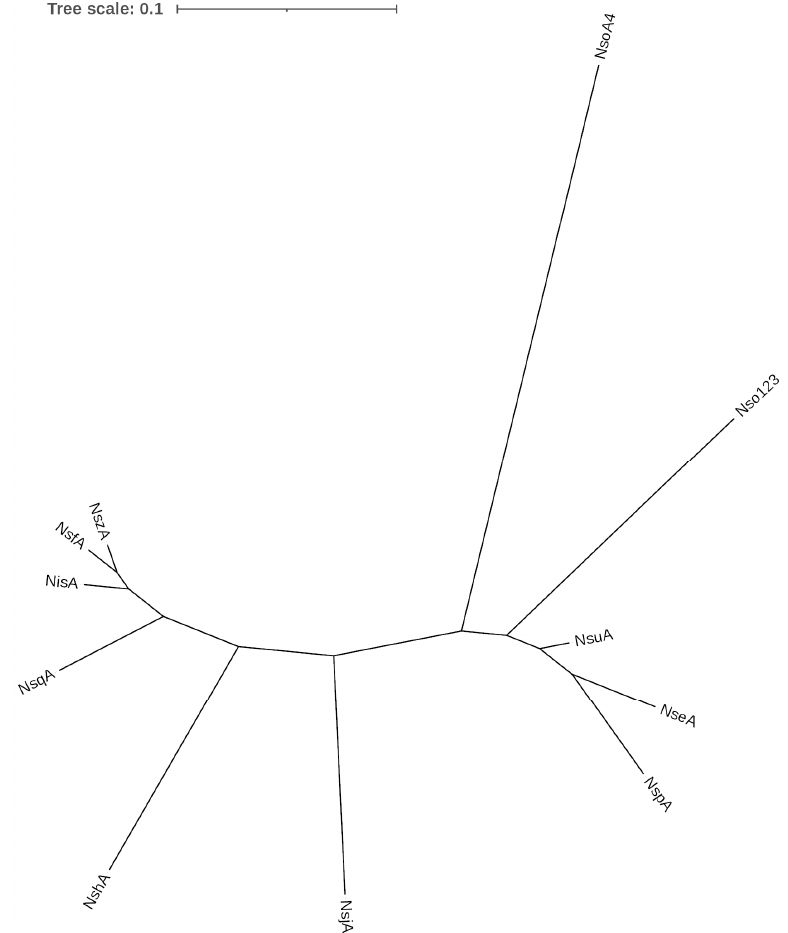
Figure 3. Dendrogram of nisin E in relation to other natural nisin variants. The tree scale represents branch length and indicates amino acid substitutions per position.